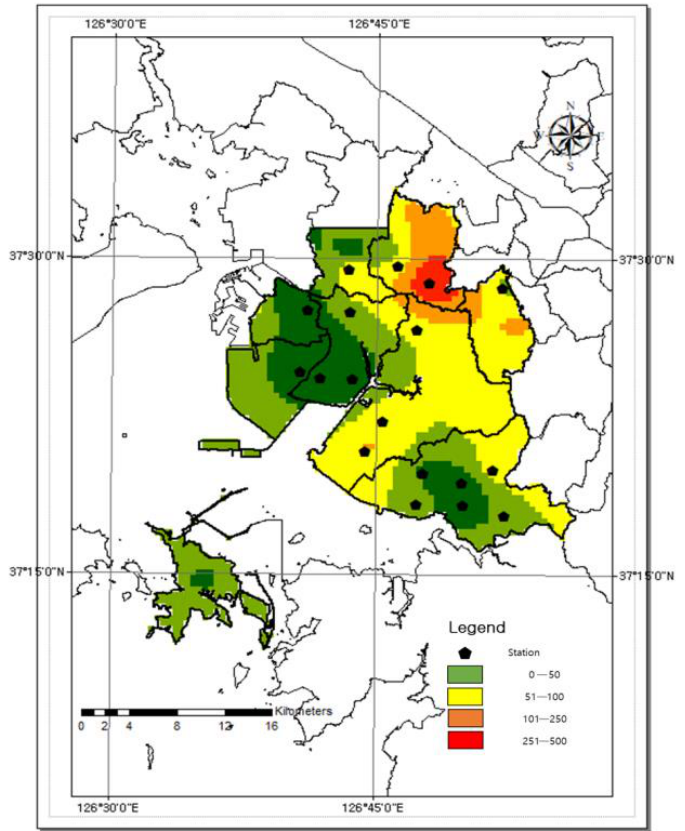
Figure 15. Spatial distribution of comprehensive air-quality index provided from ordinary kriging. Black points represent the location of air-quality stations, and green, yellow, and orange represent negligible, minor, and catastrophic air quality, respectively.